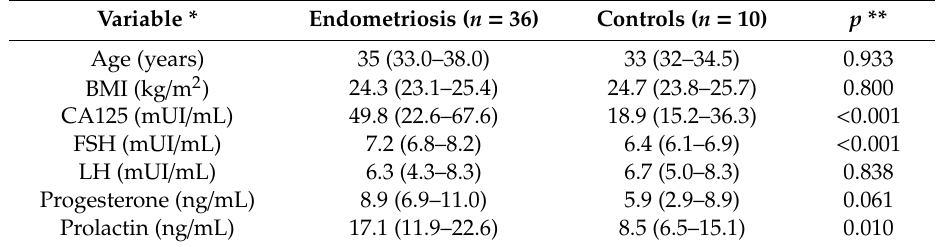
Table 1. Comparison of clinical and hormonal characteristics of women with and without endometriosis. Variable *